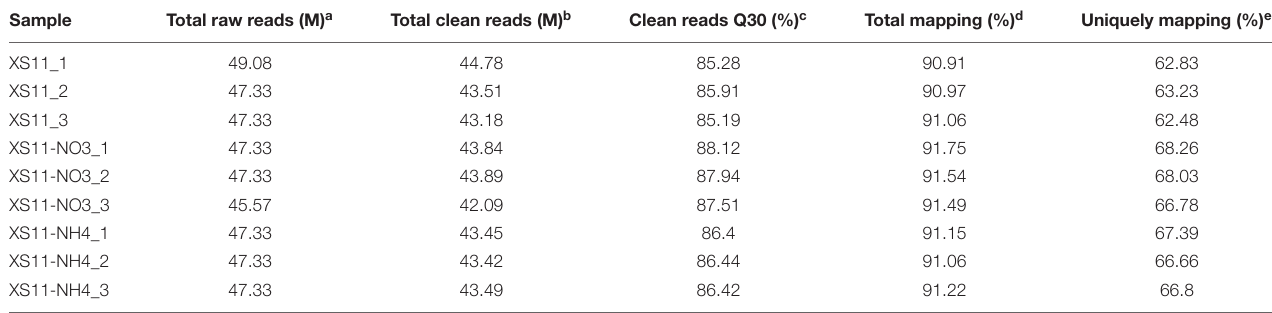
TABLE 1 | RNA sequencing statistics.